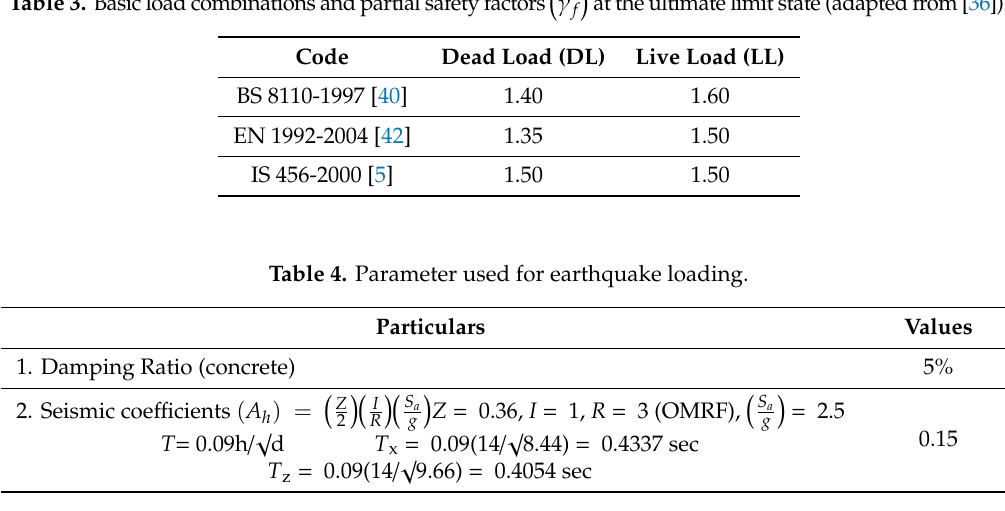
Table 3. Basic load combinations and partial safety factors